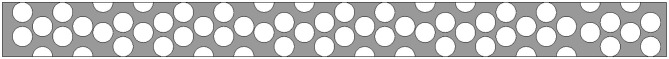
Sketch of the mono-disperse porous media used for the comparisons with available experimental data. Typical length scales used are Φ = 2.5 mm for each particle diameter and H = 2.7Φ for the geometry height. The porosity is 0.506.